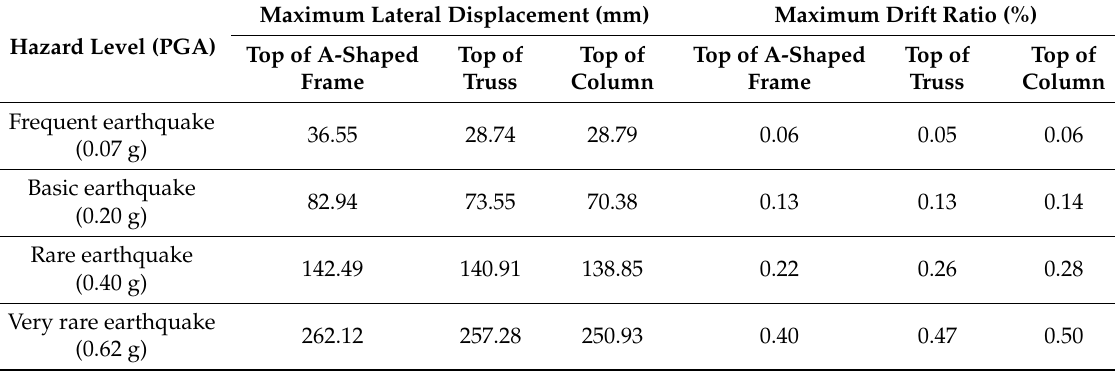
Table 8. Summary of maximum lateral displacements and drift